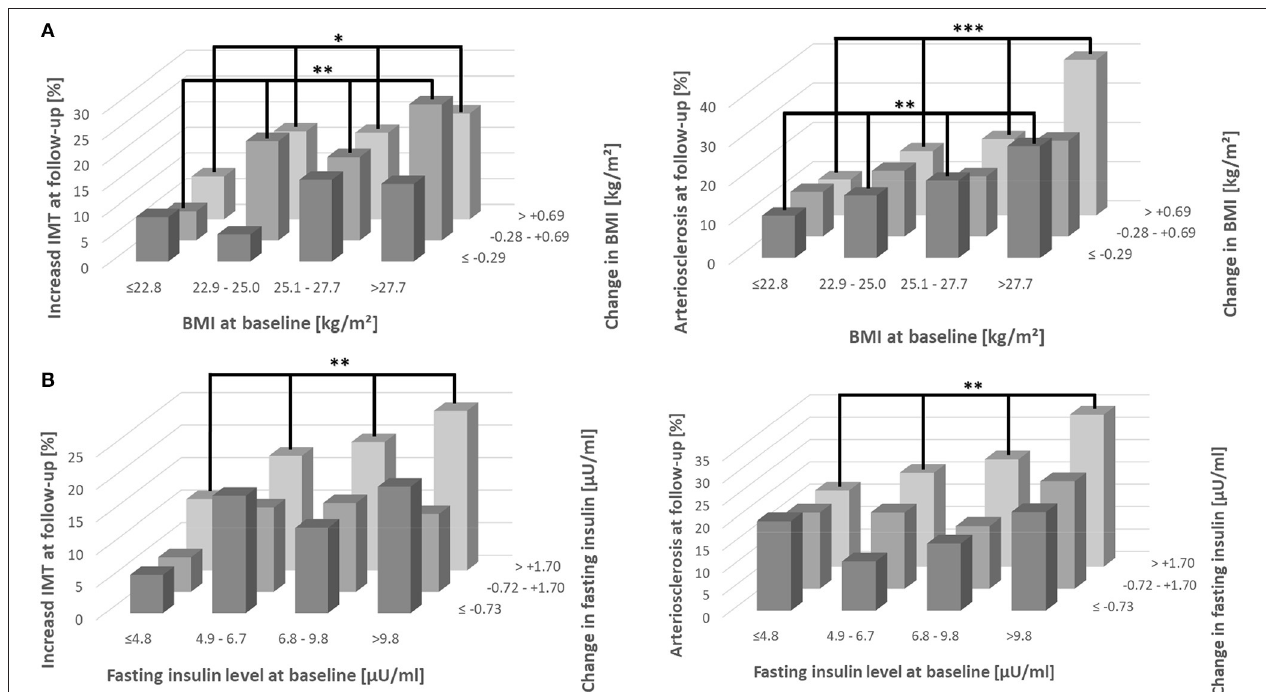
FIGURE 1 | Incidence of increased IMT and arteriosclerosis in subgroups defined by BMI (A) or fasting insulin (B) . Participants were stratified into subgroups defined by quartiles of baseline BMI or fasting insulin and tertiles of BMI or fasting insulin change during follow-up. Differences in distribution were analyzed using Chi-square test. *** p < 0.001; ** p < 0.01; * p < 0.05; IMT, intima media